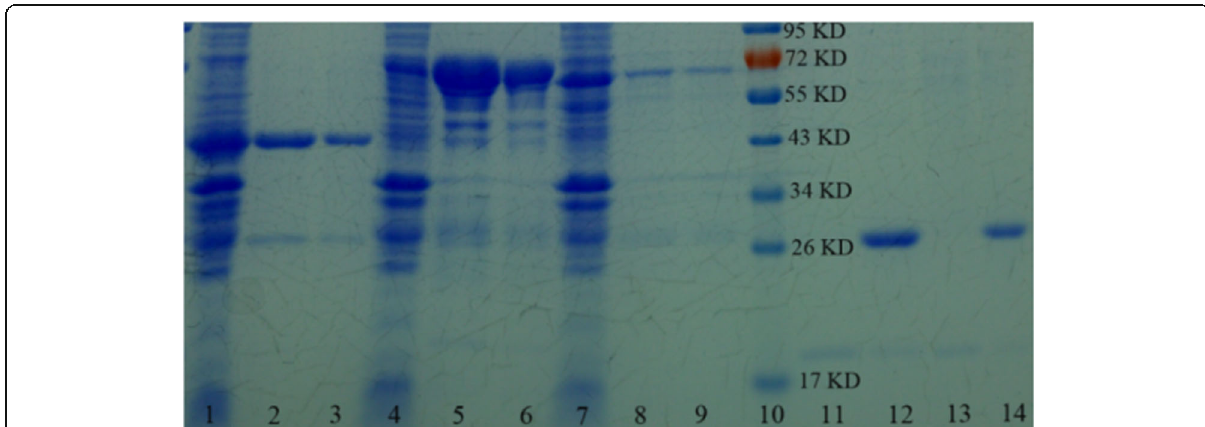
Fig. 5 SDS-PAGE analysis of the purified recombinant GPX3, OST1, and ABI2 proteins. Lanes 1, 4, and 7, E. coli lysate; lanes 2, 5, and 8, the proteins eluted from commercial Glutathione Sepharose 4B (GE Healthcare, USA); lanes 3, 6, and 9, the proteins eluted from SnO 2 /SiO 2 -GSH NSs; lane 10, the marker; lanes 11 and 13, GPX3 obtained after the GST tag is cut off from Glutathione Sepharose 4B bound GST-GPX3 and SnO 2 /SiO 2 -GSH NSs bound GST-tagged GPX3; lanes 12 and 14, GST tag eluted from Glutathione Sepharose 4B and SnO 2 /SiO 2 -GSH